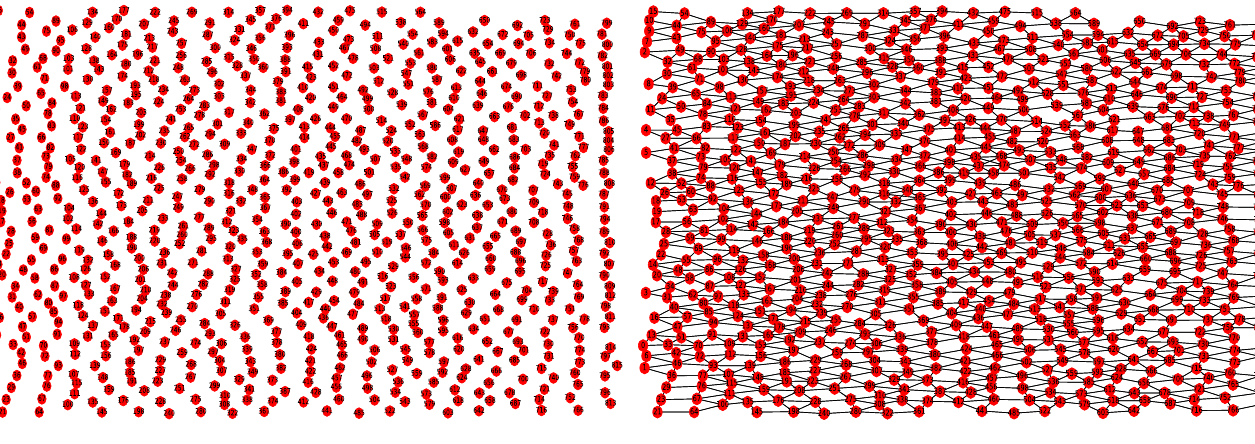
Figure 1. Construction of graph network. ( Left ) Partial particles of a particle system with a disorder of 1 to 1. ( Right ) Graph network constructed by one-hop neighbors of particles in